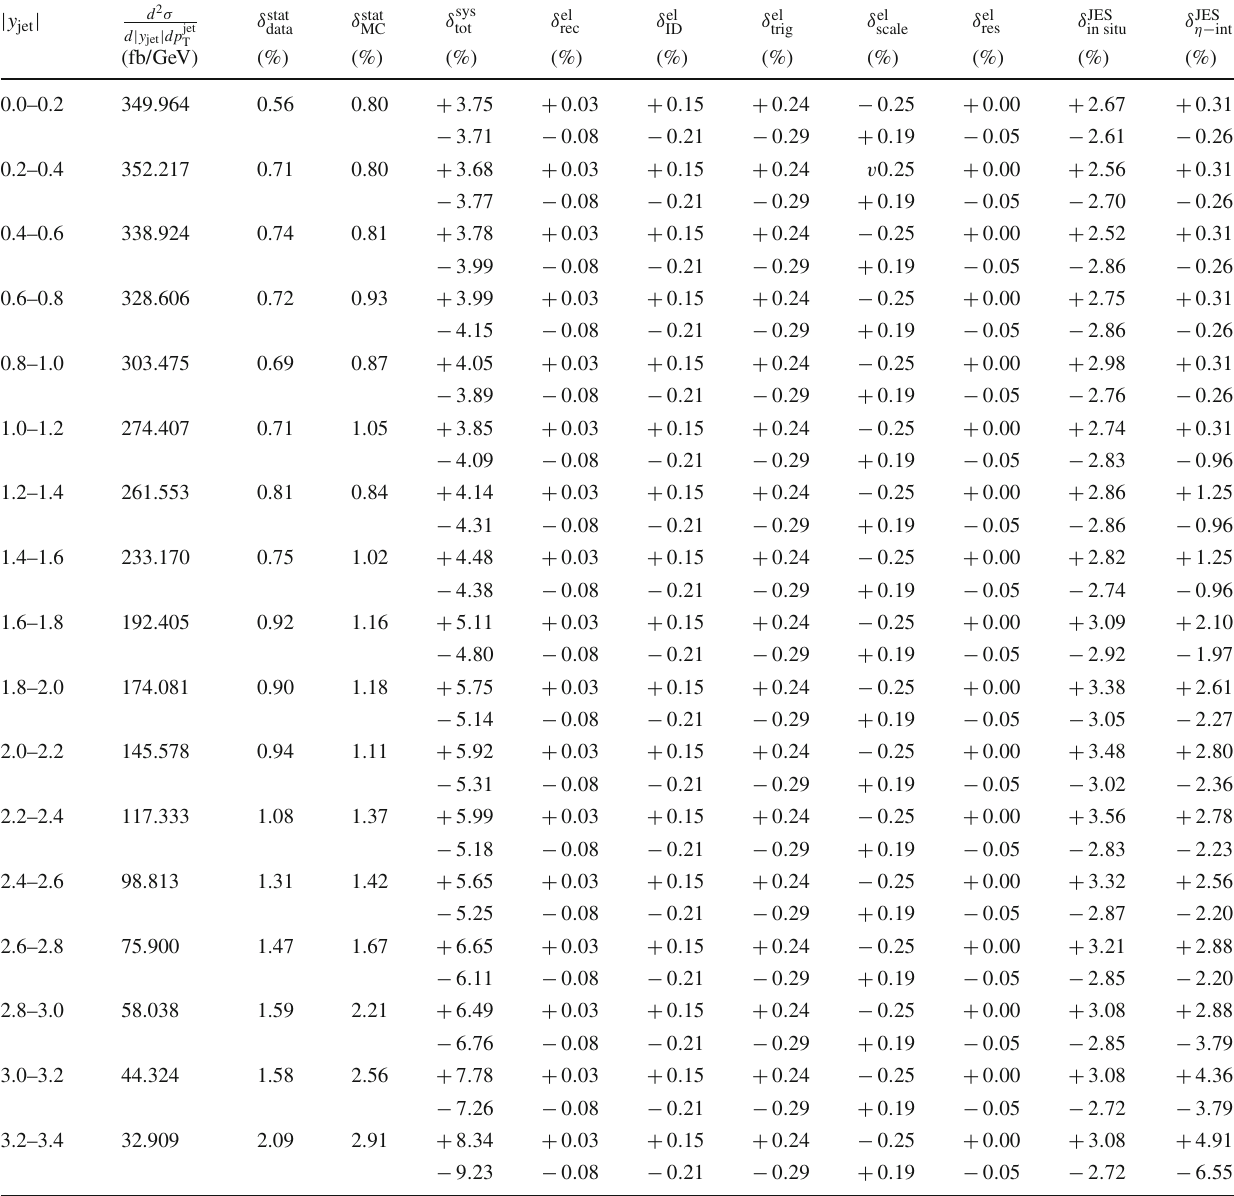
Table 4 The measured double-differential Z + jets production cross- sections as a function of | y jet | in the 50GeV < p jet δ stat and δ stat are the statistical uncertainties in data and MC simulation, data MC respectively. δ sys tot is the total systematic uncertainty and includes the fol- lowing components: uncertainties due to electron reconstruction ( δ el rec